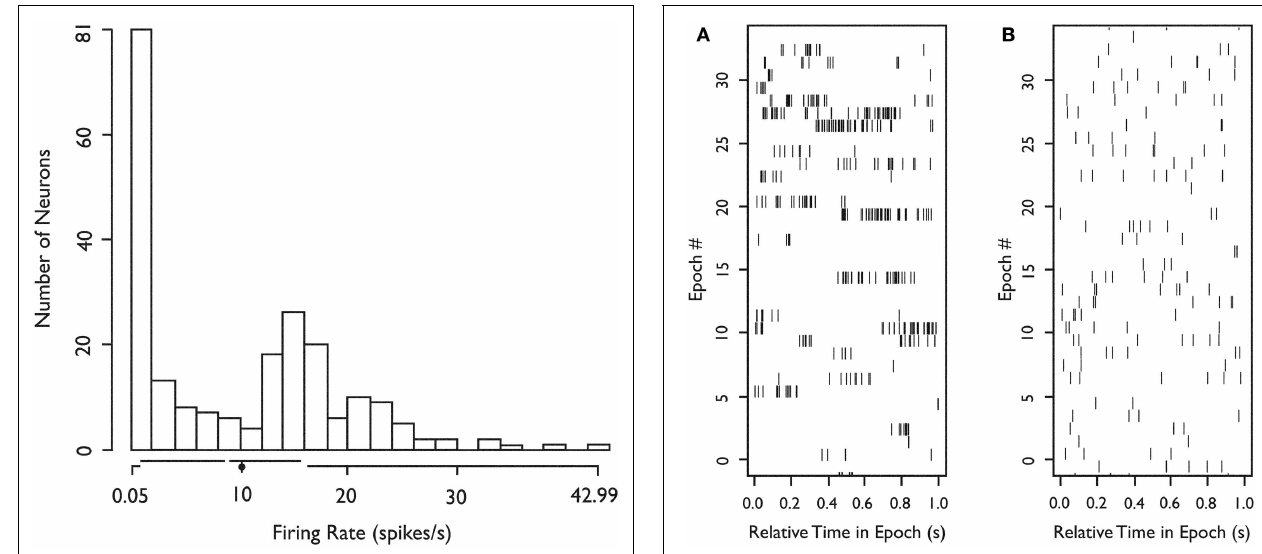
FIGURE 2 | Firing of two neurons during 33s of continuous in situ recording . Raster plots of spike occurrence times. X -axis: relative time of spike occurrence in each 1-s interval; y -axis: number of 1-s sequential intervals within the recording epoch. (A) Raster for a neuron with a tendency to burst ( B isi = 0.9). (B) Raster for a neuron with more uniform firing ( B isi = 0.039). Used with permission from Barrow Neurological Institute.